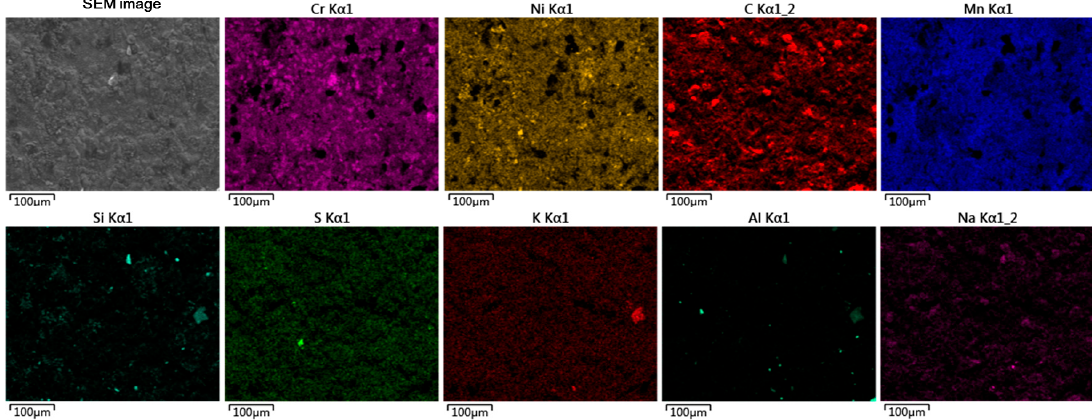
Figure 10. The surface analysis of sample #4 based on EDS mapping.